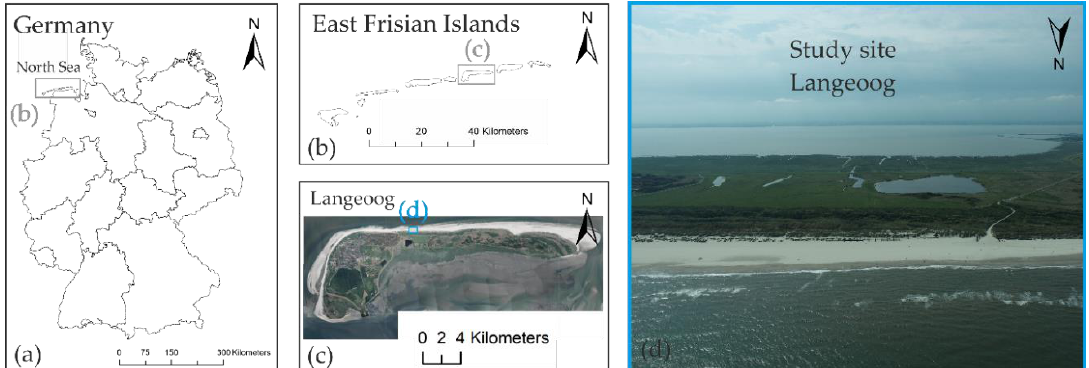
Figure 1. ( a ) Location of the study site in Germany (adapted from [41], with permission from © GeoBasis-DE / BKG, 2020) belonging to the ( b ) East Frisian Islands, federal state Lower Saxony (adapted from [41], with permission from © GeoBasis-DE/ BKG, 2020) as part of the ( c ) island Langeoog (adapted from [42] with permission from © dl-de/by-2-0, 2020), as well as the location of the ( d ) study site in the Northern part of Langeoog.